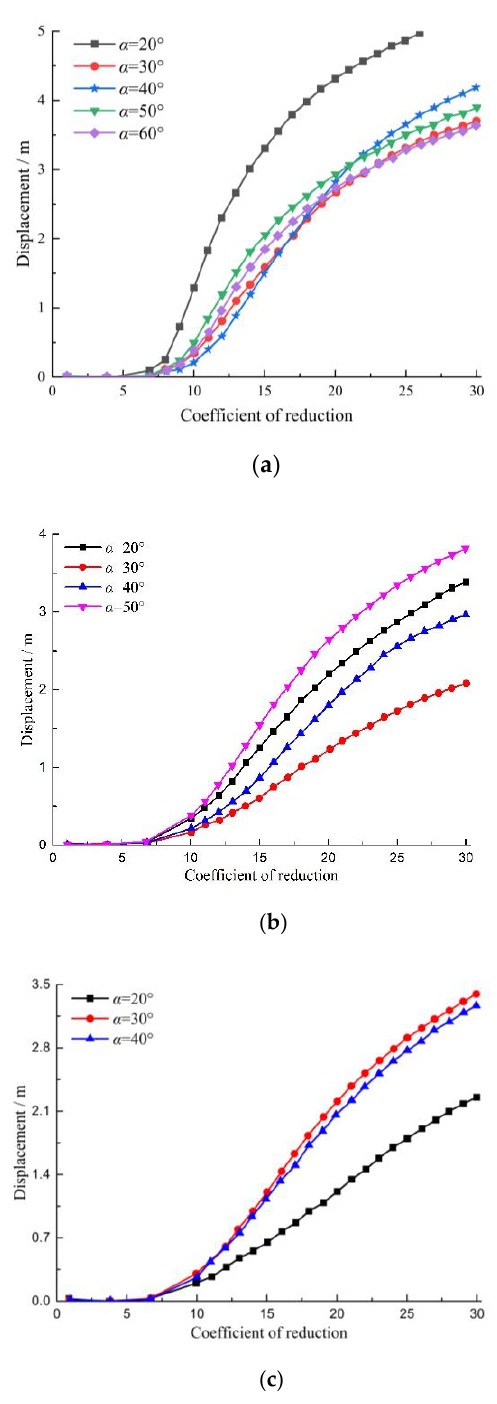
Figure 7. Variation curve of displacement at the apex of ridge slope with reduction factor under different α ; (a) H =10m, β =70°; (b) H =10m, β =60°; (c) H =10 m, β =50°. different α ; ( a ) H = 10 m, β = 70 ◦ ; ( b ) H = 10 m, β = 60 ◦ ; ( c ) H = 10 m, β = 50 ◦